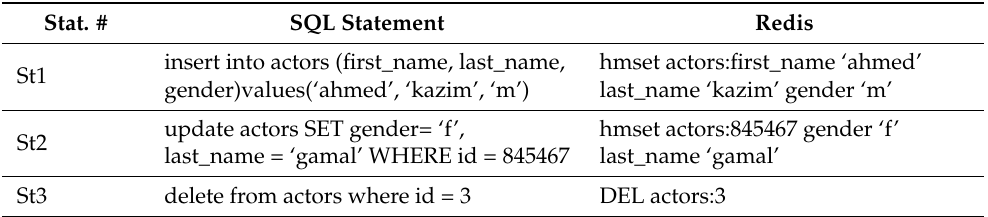
Table 4. Translation from SQL to Redis using the proposed